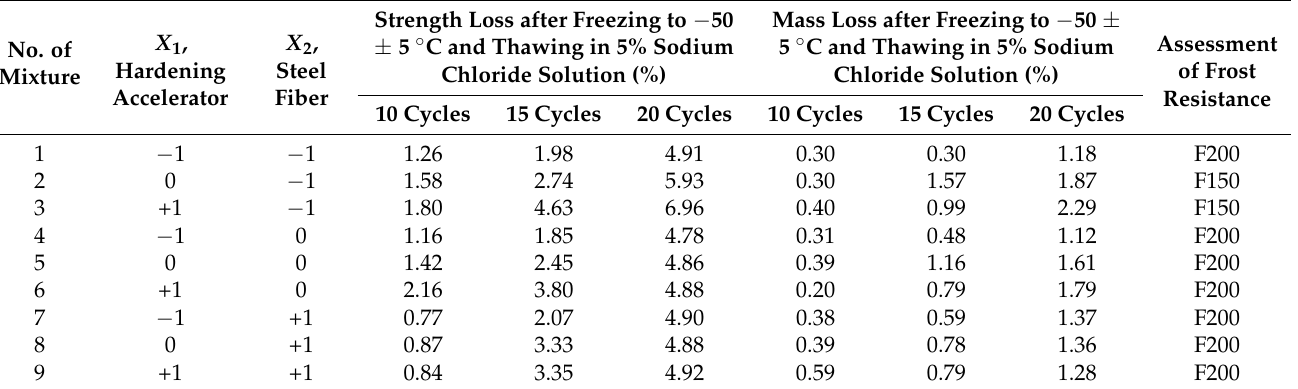
Table 4. Determination of concrete frost resistance according to DSTU B V.2.7-49-96 “Concrete. Acceler- ated methods for determining frost resistance with repeated freezing and thawing” (third method).